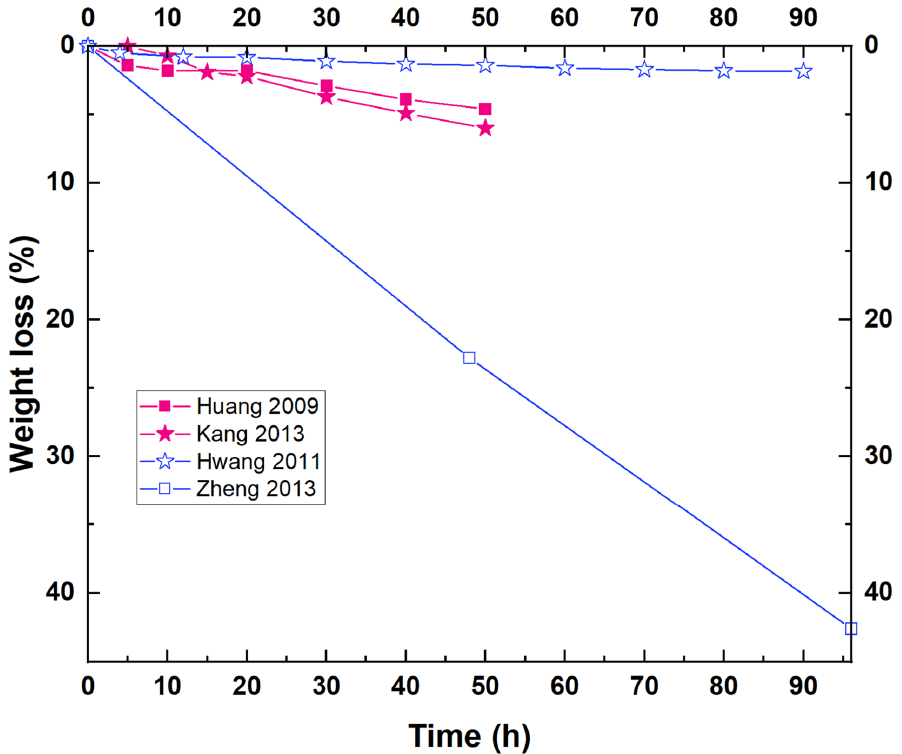
Figure 8. Weight loss curves corresponding to various enzymatic degradation studies of PBS by the action of a lipase from Pseudomonas cepacia . Experimental conditions differ from one study to another, although the same enzyme is used.